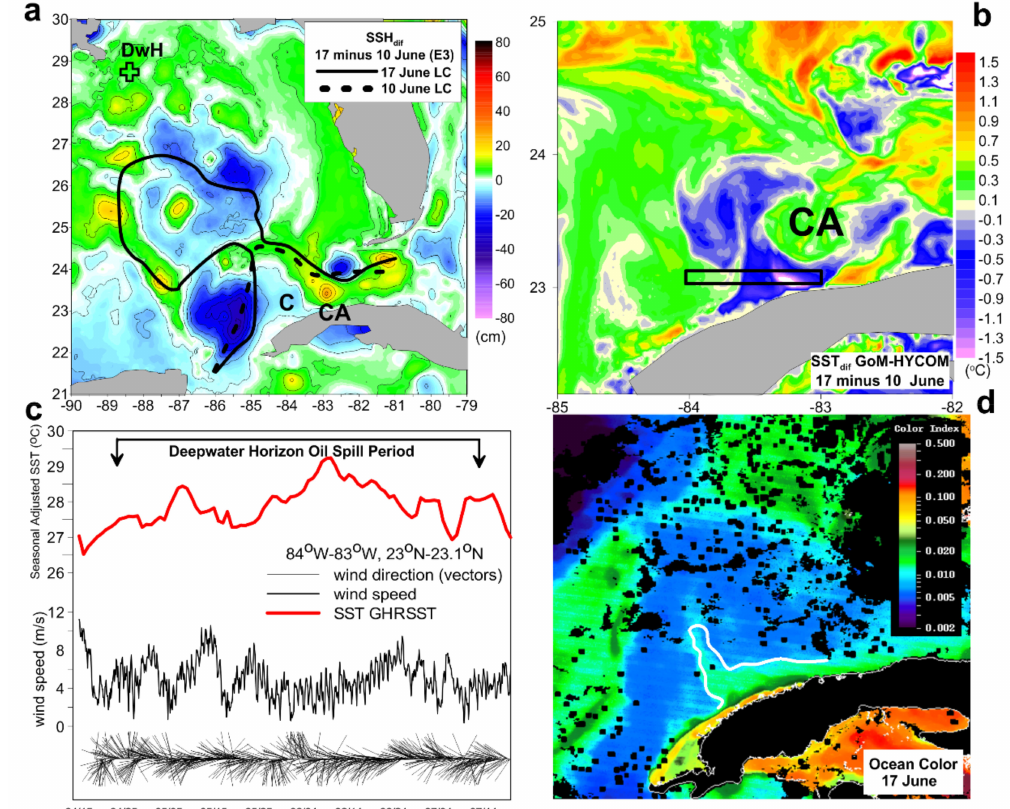
Figure 10. (a) Sea surface height difference (SSHdif) and (b) sea surface temperature difference (SST dif ) between the 17 June (period E3) and 10 June fields simulated by the GoM-HYCOM 1/50 model. The cyclonic feature (C) and the CubAN (CA) are indicated. The simulated SSH 17-cm contours of 17 and 10 June are marked with black solid and dashed lines, respectively, in ( a ). The location of the DwH platform is marked in ( a ) with a cross. ( c ) Evolution of satellite SST (Group for High Resolution Sea Surface Temperature (GHRSST) data, red line) and 3-hourly European Centre for Medium-Range Weather Forecasts (ECMWF) wind speed (black line) and direction (black vectors) during the entire oil spill period (note that all direction sticks have same length), averaged over the black line box in ( b ), and ( d ) satellite ocean Color Index (CI) on 17 June, depicting the upwelling front (white solid